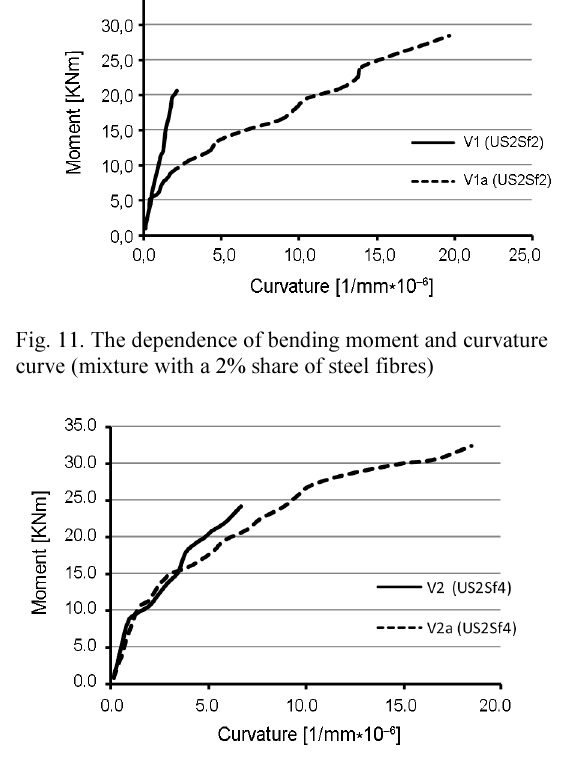
Fig. 12. The dependence of the bending moment and curvature curve (mixture with a 4% share of steel